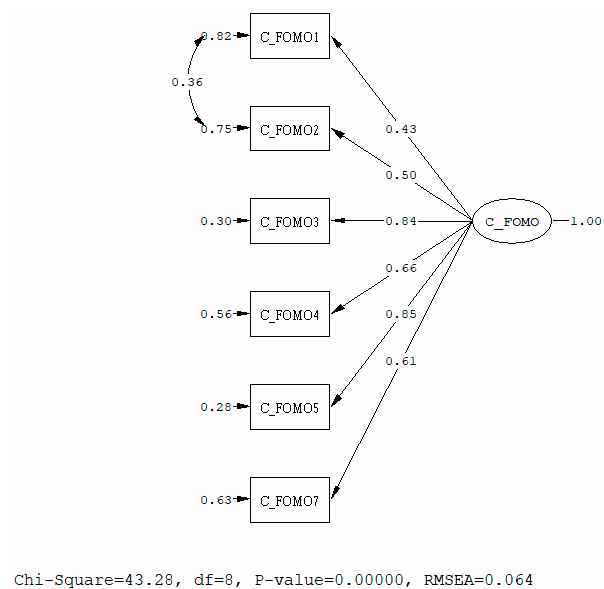
Figure 1. Confirmatory factor analysis on CIFS.